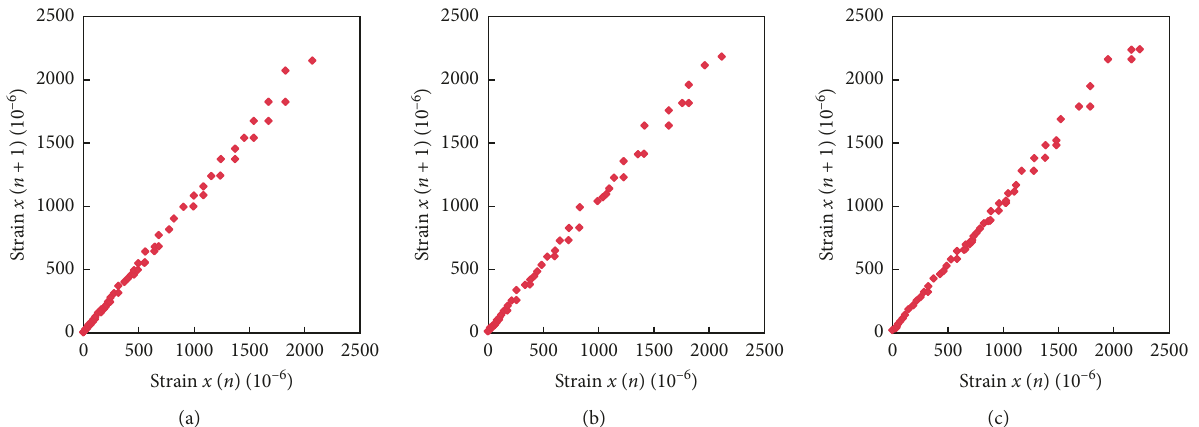
Figure 12: Evolution of each fitted strain series. (a) Fitted result of Group 1. (b) Fitted result of Group 2. (c) Fitted result of Group